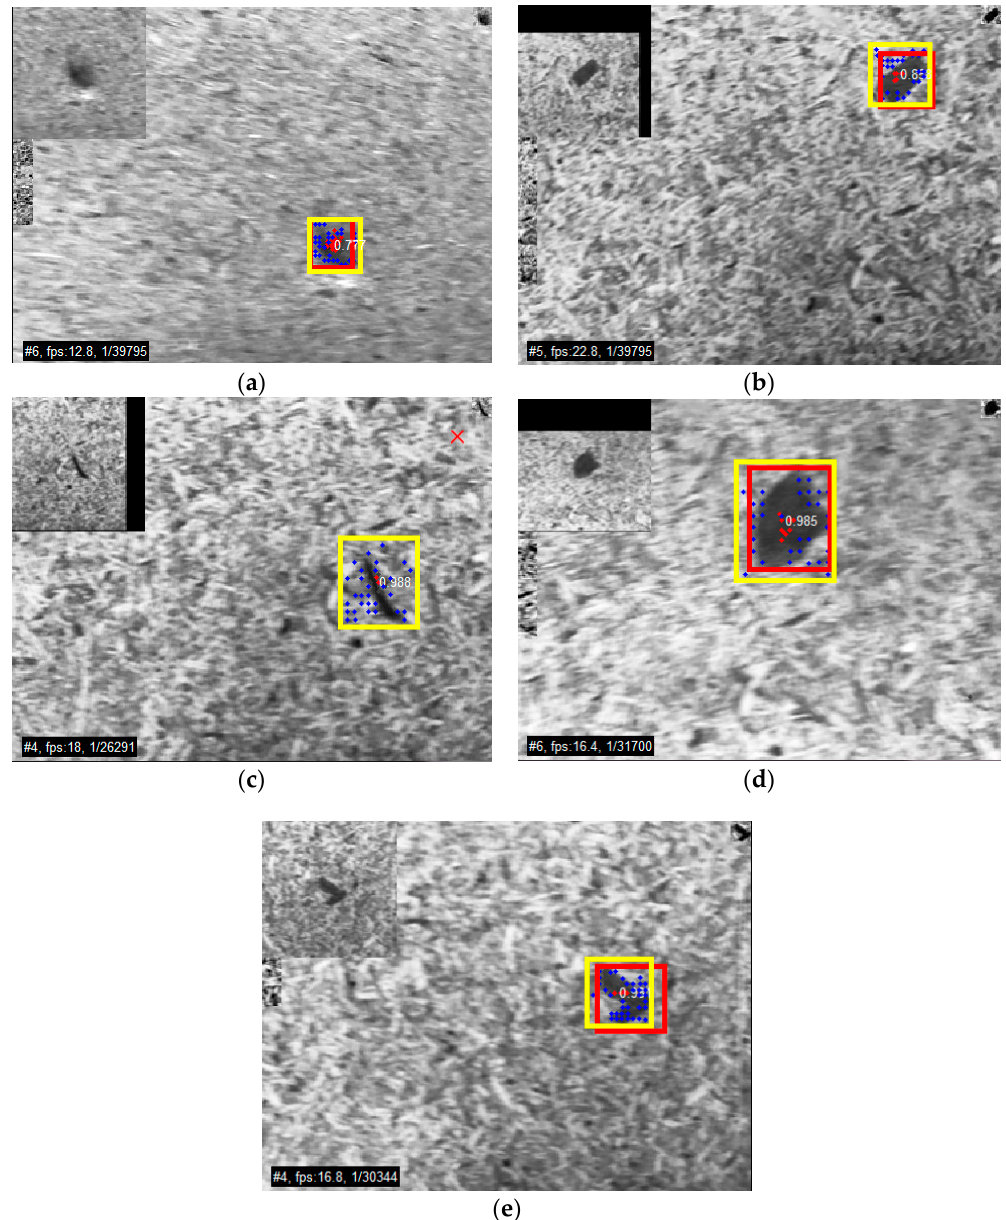
Figure 5. Comparison of tracking results of surface defects: ( a ) defect a ; ( b ) defect b ; ( c ) defect c ; ( d ) defect d ; ( e ) defect e .